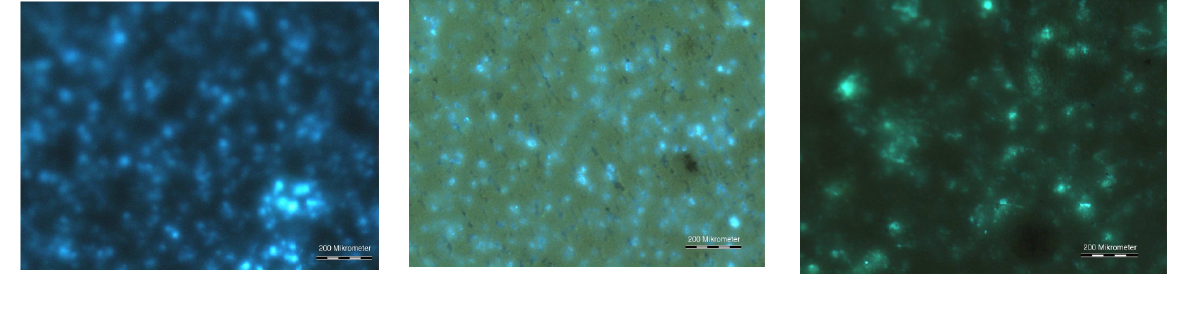
Figure 12 . AC-luminescence after heat treatment, viewed through the substrate. Left: after 200 – C. Center: after 500 – C. Right: after 600 – C. Scale bar: 200 µ